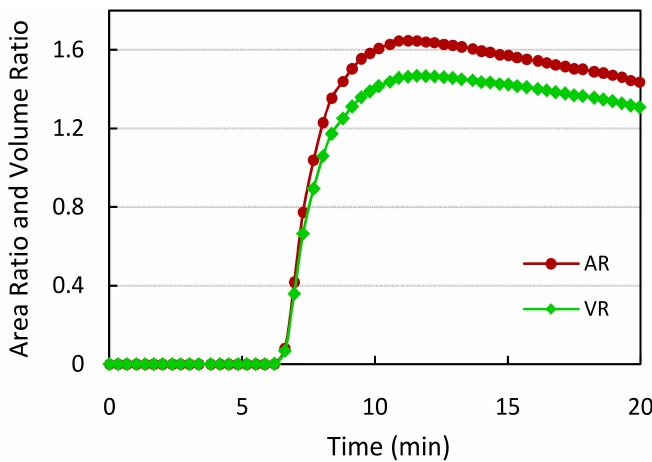
Figure 11. The trend of area ratio (AR) and volume ratio (VR) values measured with increasing time for a sample HbA1C test